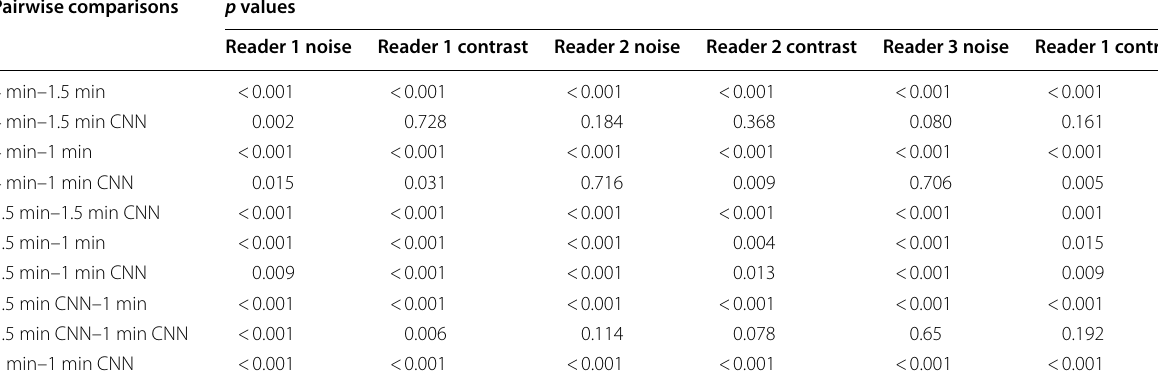
Significant p value is < 0.005 after Bonferroni correction